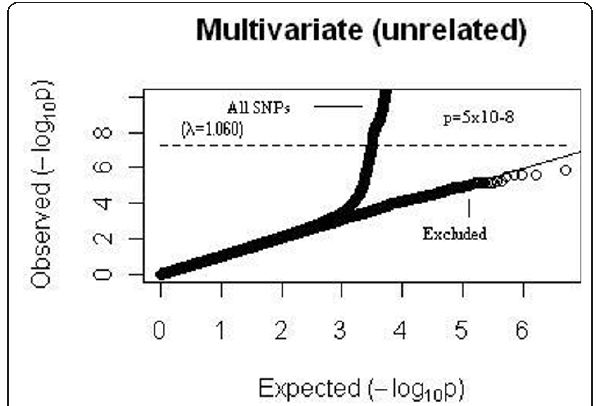
Figure 3 Q-Q plot of multivariate analysis . Black points correspond to SNPs included in the analyses. The 45° line refers to no significant association. The dotted line corresponds to p-value of 5 × 10 -8 . “ Excluded ” line is where SNPs that were found in significant regions (genes) in univariate analyses were